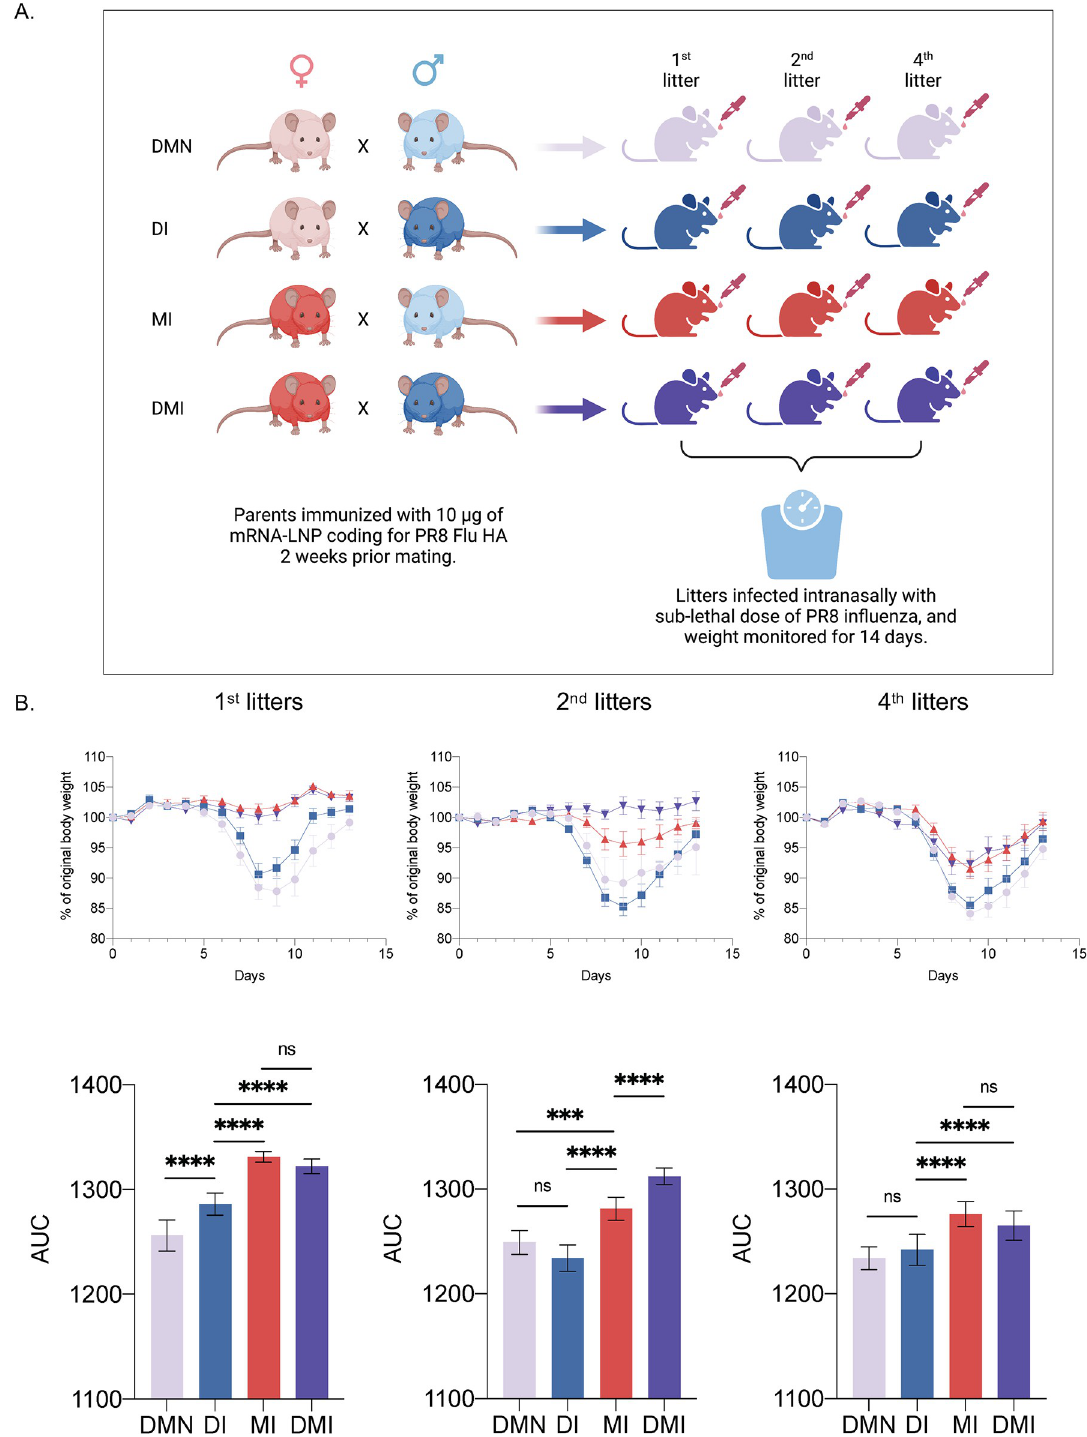
Fig 6. Immune changes induced by the mRNA-LNP platform can be inherited. A ). Experimental model. Adult WT B6 male and female mice were intradermally immunized with 10 μ g of mRNA-LNP coding for influenza PR8 HA. Two weeks post-immunization the mice were mated. Non-immunized males mated to non-immunized females served as controls (DMN; dad-mom non-immunized). Immunized males with unimmunized (DI; dad immunized) or immunized females (DMI; dad-mom immunized), and immunized females with unimmunized males (MI; mom immunized). Offspring from 1 st , 2 nd , and 4 th litters at eight-ten weeks of age were